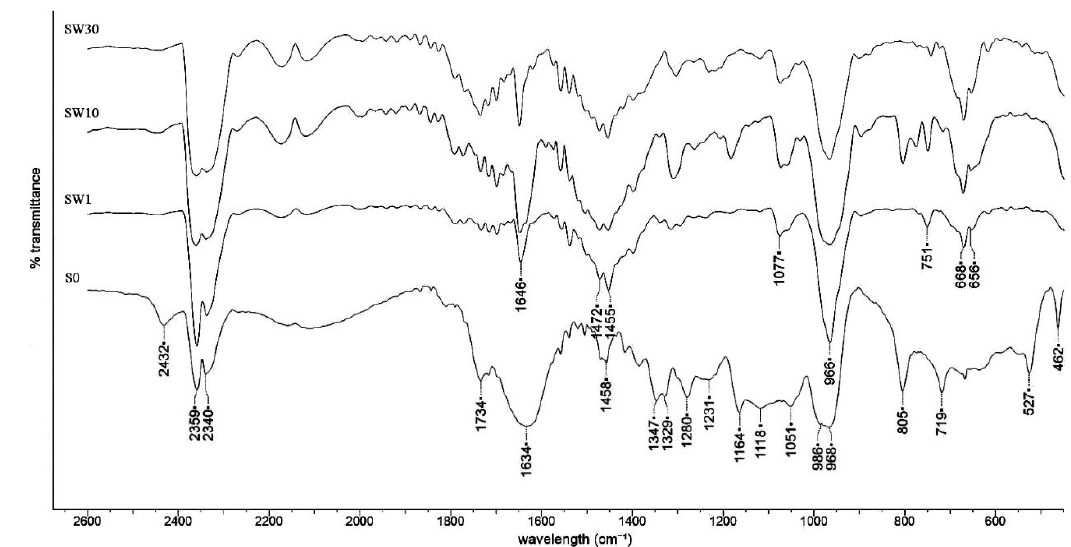
Figure 4. FT-IR spectra for PFSA and PFSA–RF samples using water as the solvent in the impregnation process.